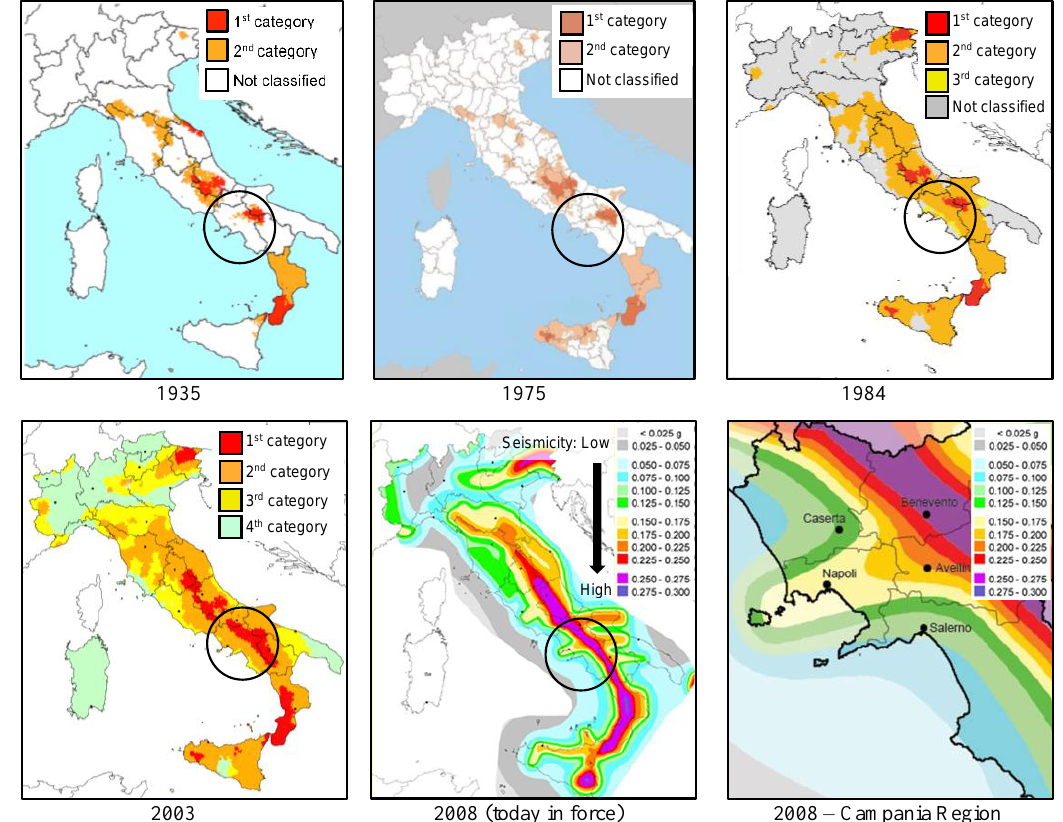
Figure 7. Historical seismicity in Italy: hazard map from 1935 to 2008, with a special focus on the Campania Region.